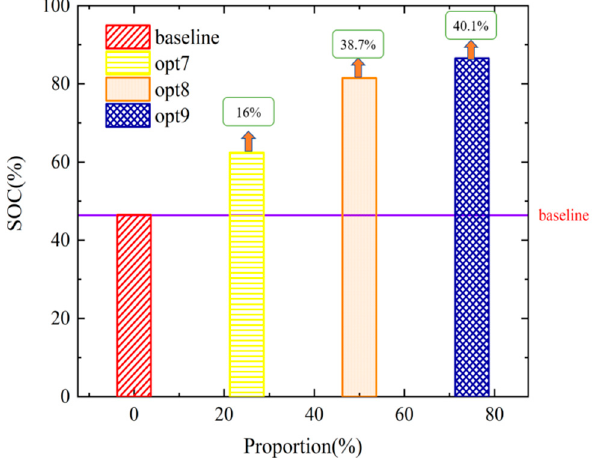
Figure 10. SOC of the cylinder before and after optimization.